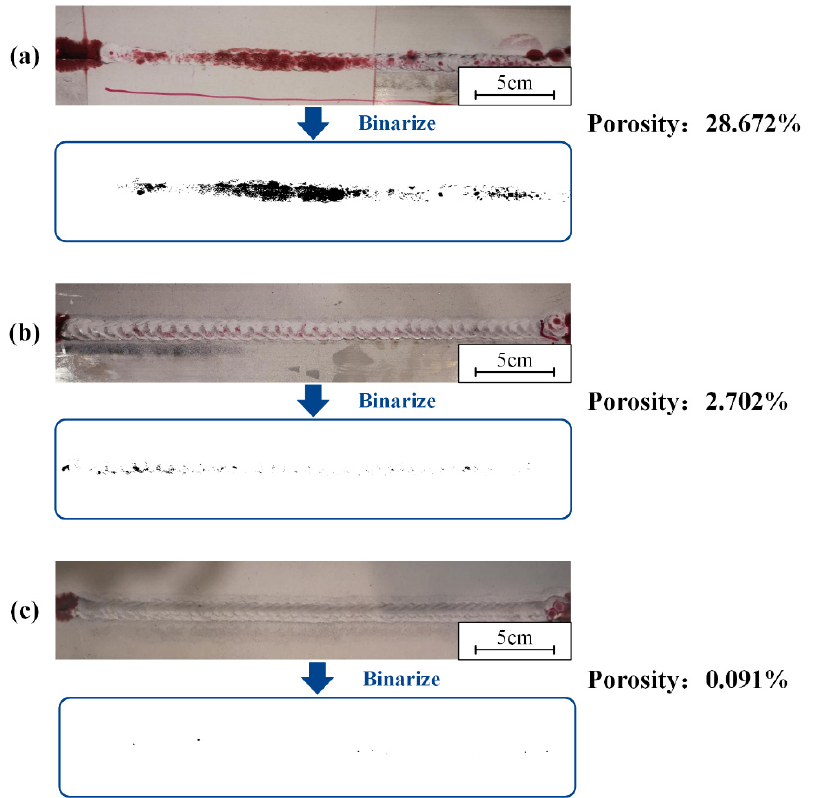
Figure 11. The result of the permeation testing and the porosity at sample with: ( a ) oil; ( b ) water; ( c ) laser cleaning.